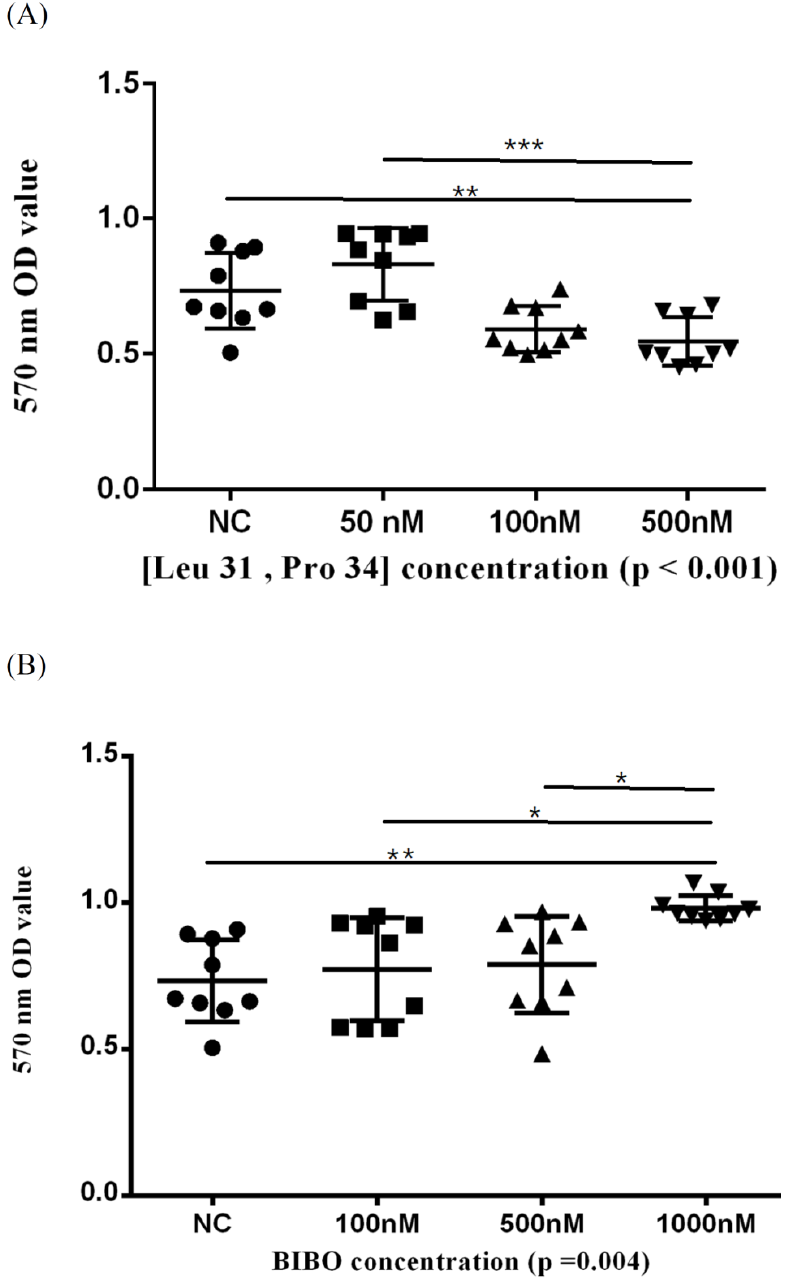
Figure 4. The 570 nm optic density (OD) values of BMSCs treated in serial concentrations of Y1R agonist (Leu 31, Pro 34) ( A ) and antagonist BIBO3304 ( B ) in MTT assay. Respective p -values for post-hoc analysis: ( A ) NC-500 nM: 0.008; 50–500 nM: <0.001; ( B ) NC-1000 nM: 0.004; 100–1000 nM: 0.018; 500–1000 nM: 0.032 (* p < 0.05, ** p < 0.01, and *** p < 0.001). The black triangles/dots/squares indicate the information concerning the respective 570nm OD values for respective